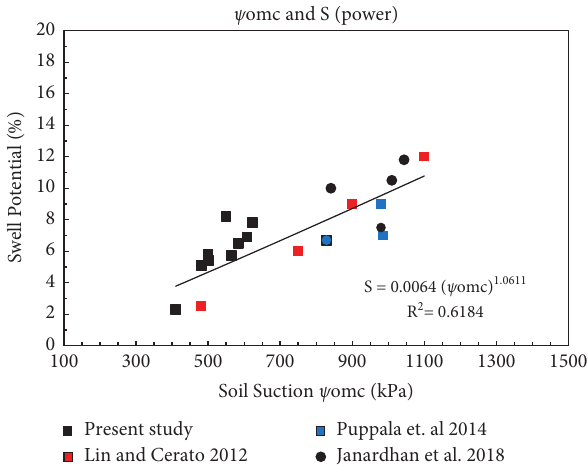
Figure 15: Representation of the novel correlation (power) for the swell potential